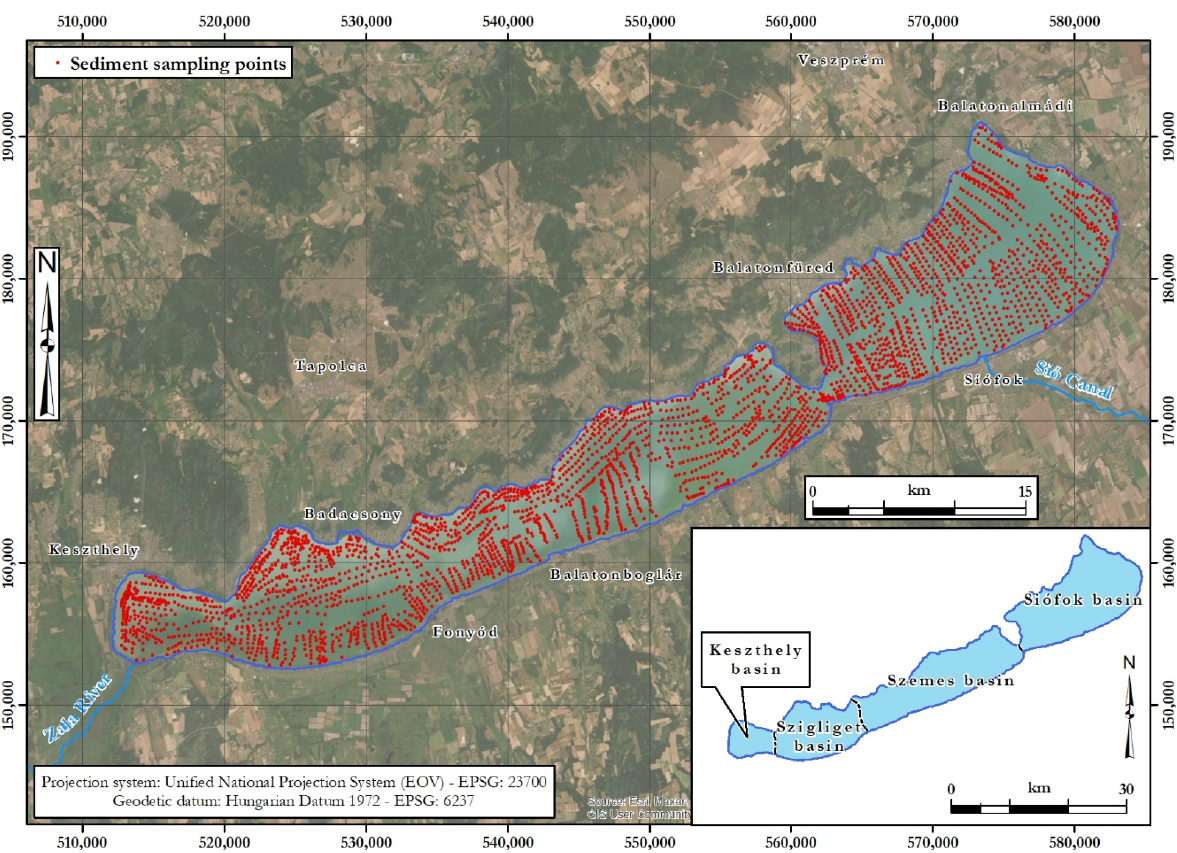
Figure 1. Location of sampling points ( n = 3340) across Lake Balaton. The inset map (bottom right) shows the lake basins (from west to east): Keszthely, Szigliget, Szemes, and Siófok basin.